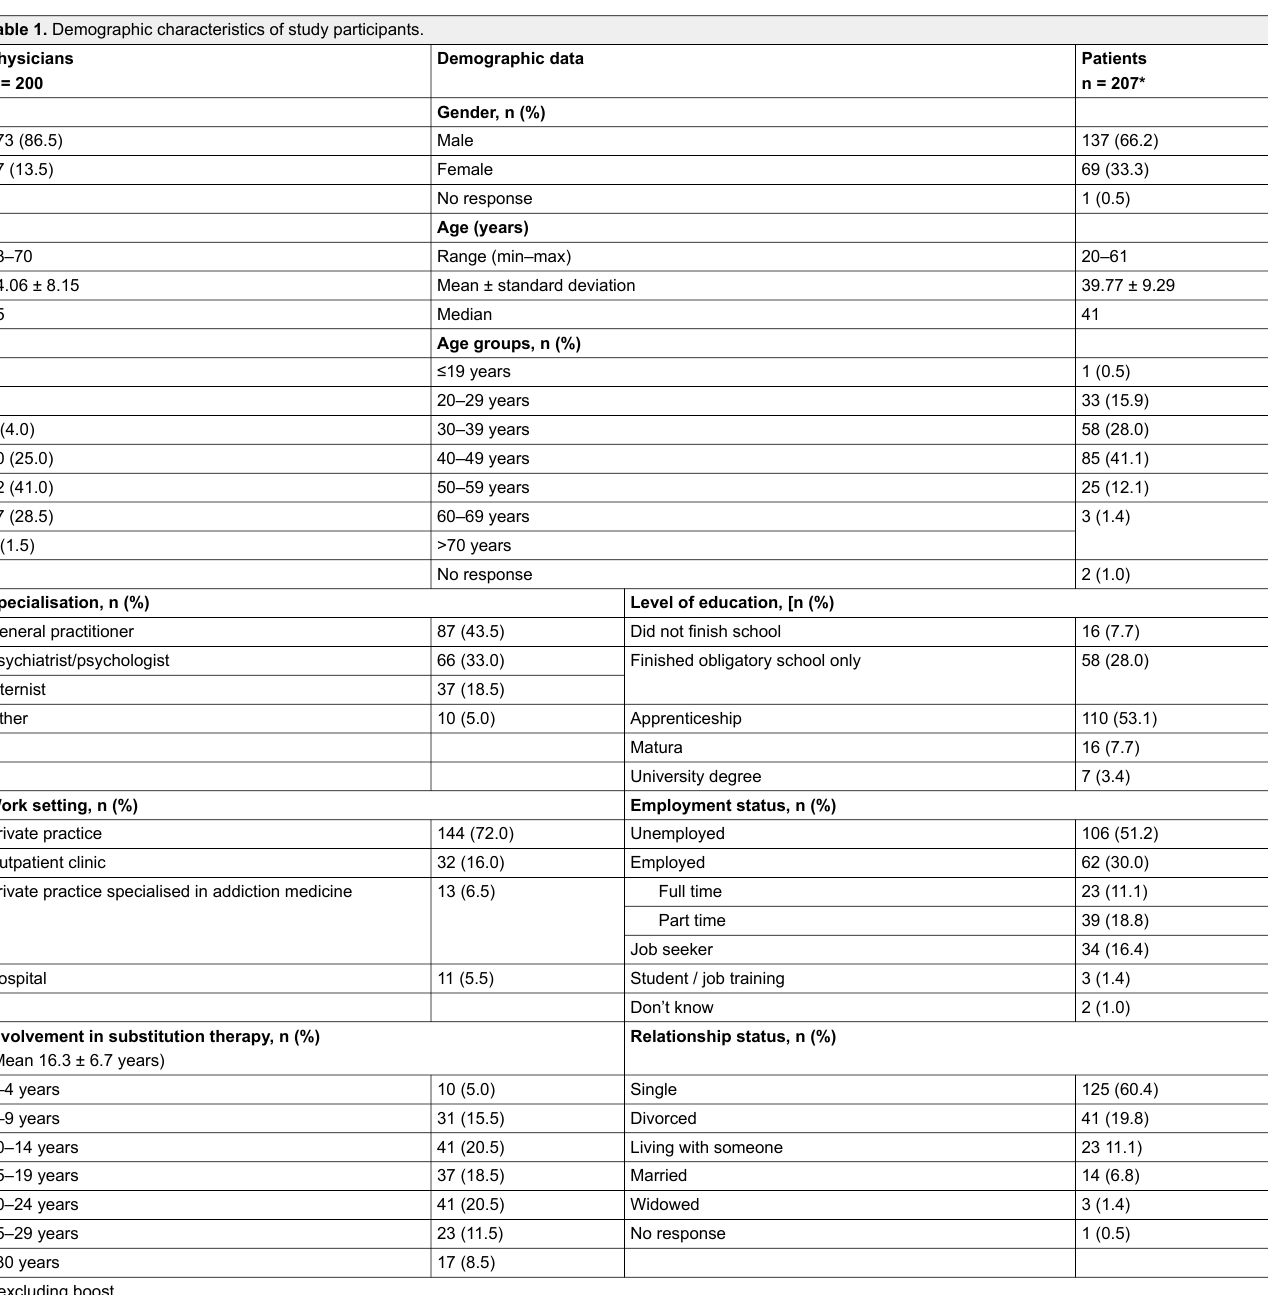
Table 1. Demographic characteristics of study